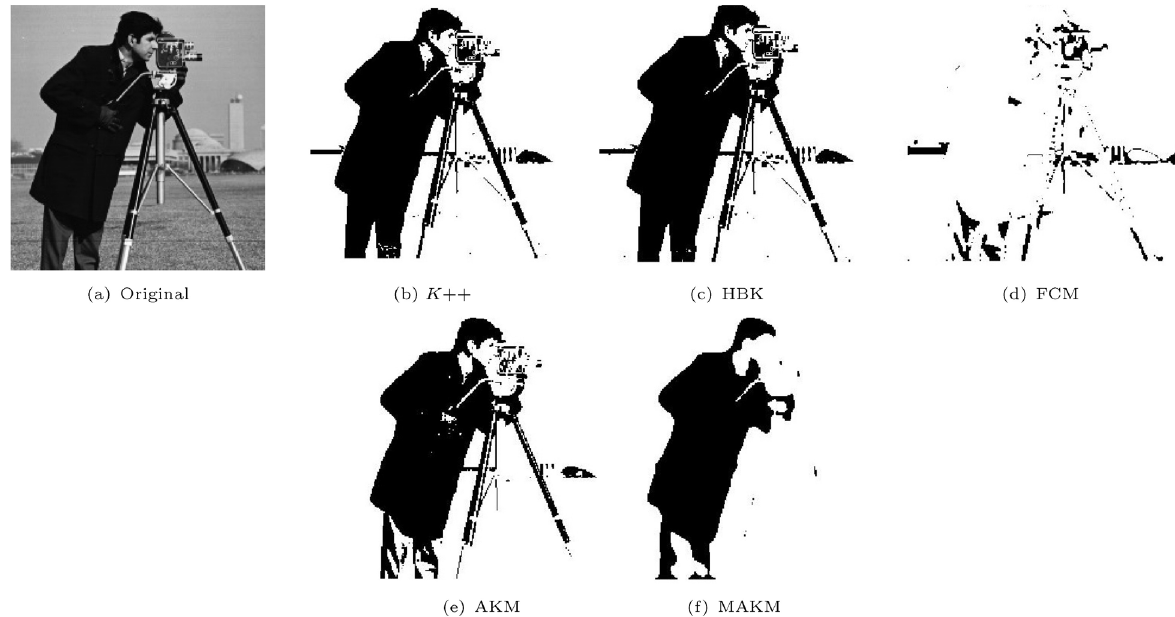
Fig. 4 Cameraman-labeled image segmented using various approaches.